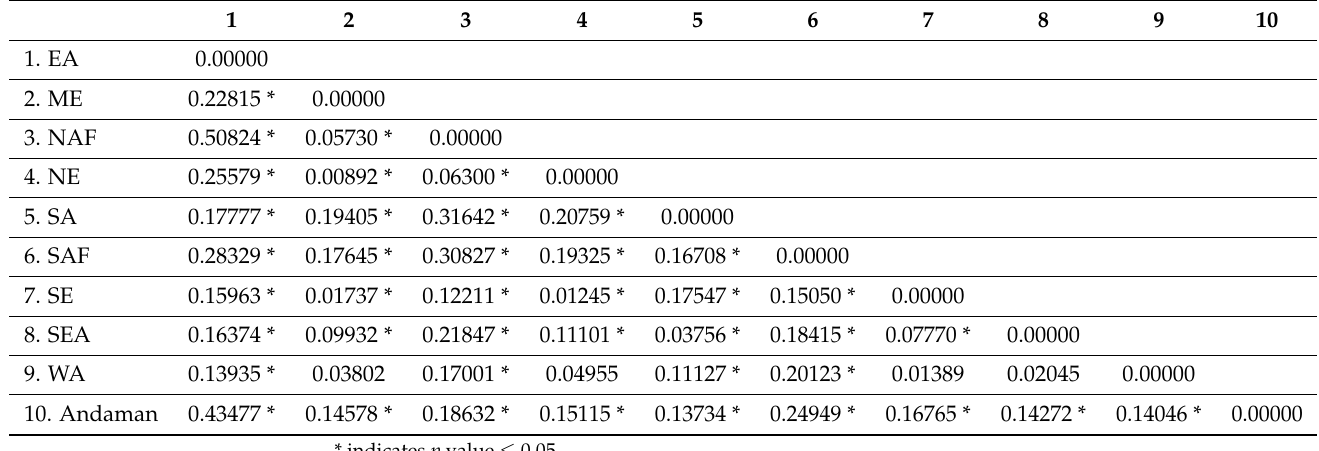
Table 1. Pairwise FST values of haplogroup A goats of Andaman and other different regions.